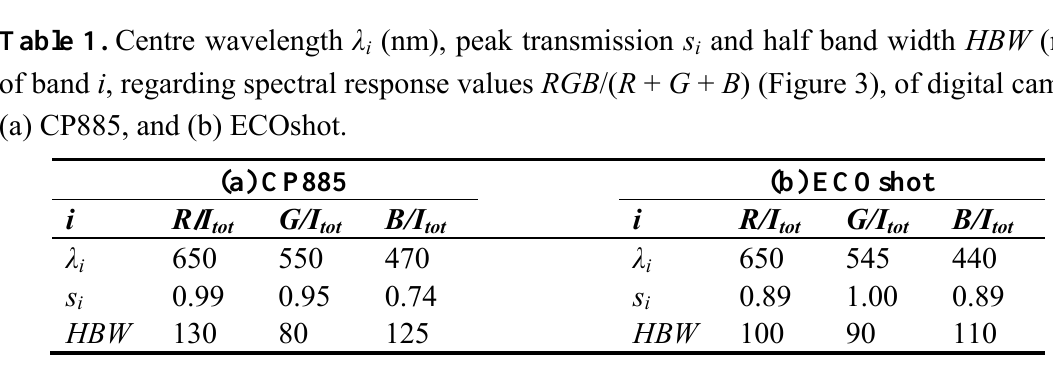
(nm), peak transmission s and half band width HBW (nm) i i